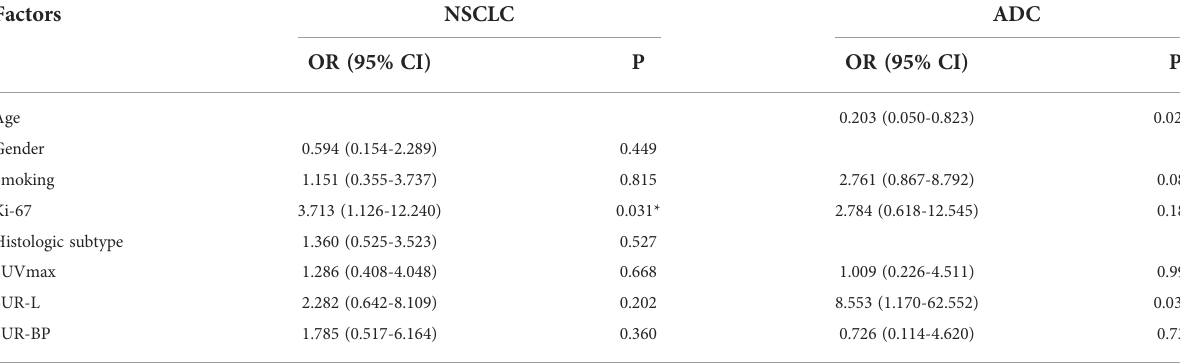
TABLE 3 Multivariate analysis of the relationship between PD-L1 expression and related variables.